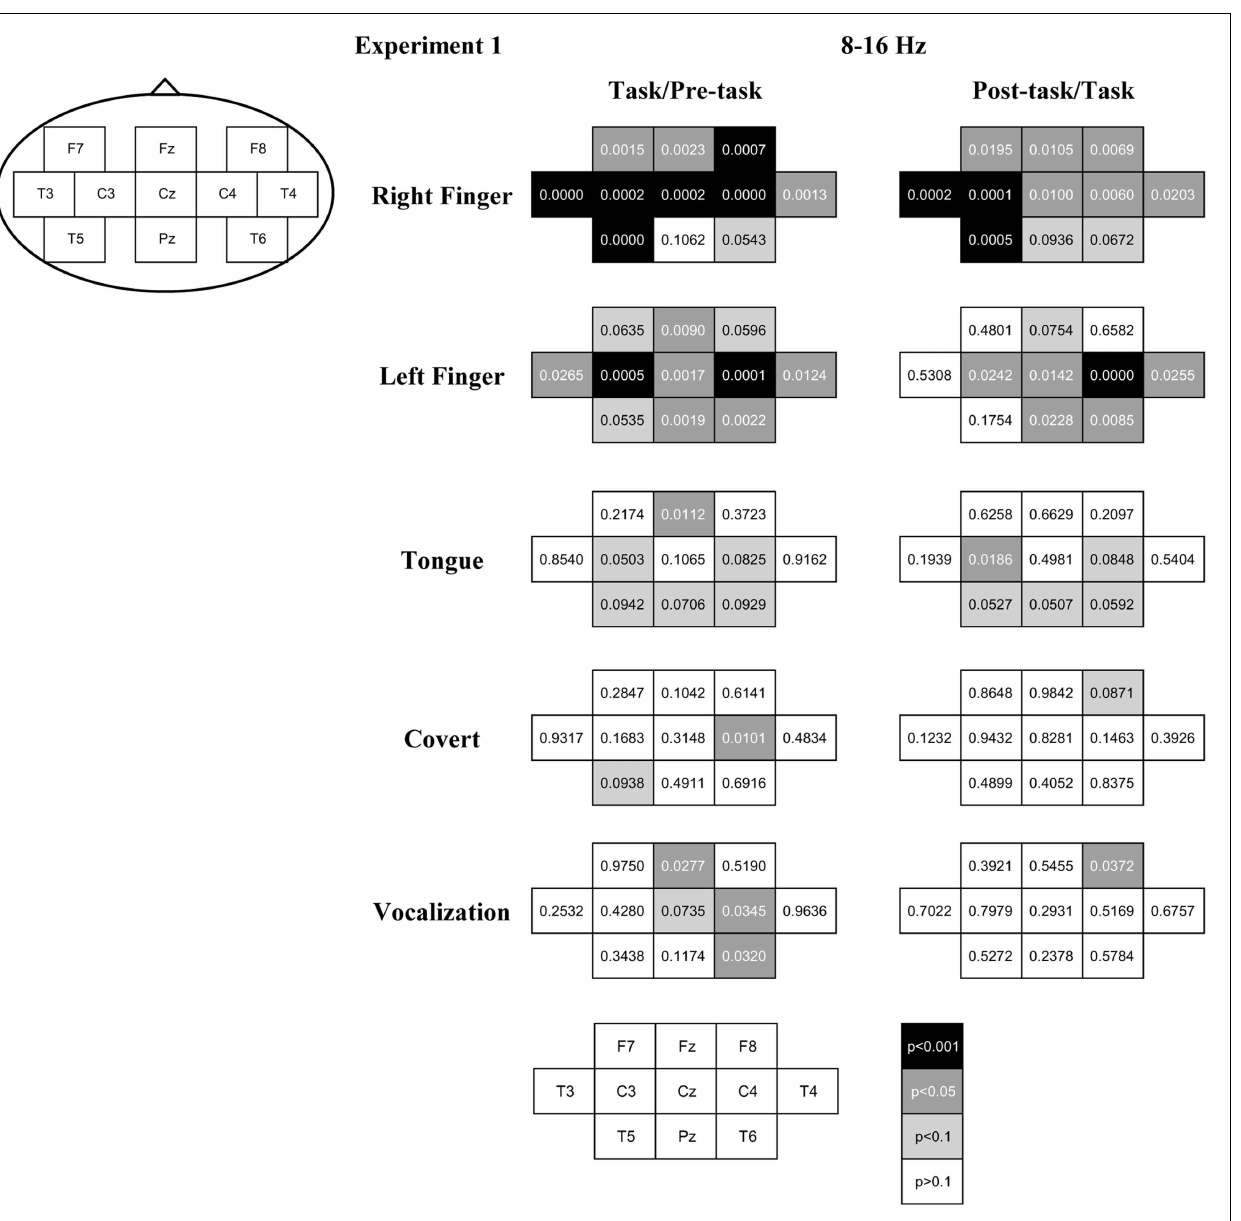
FIGURE 3 |The p -value of the t -statistics is shown at each recording site with gray scale: black, gray, light gray, and white indicate p < 0.001, p < 0.05, p < 0.1, and p > 0.1, respectively (see also Figure